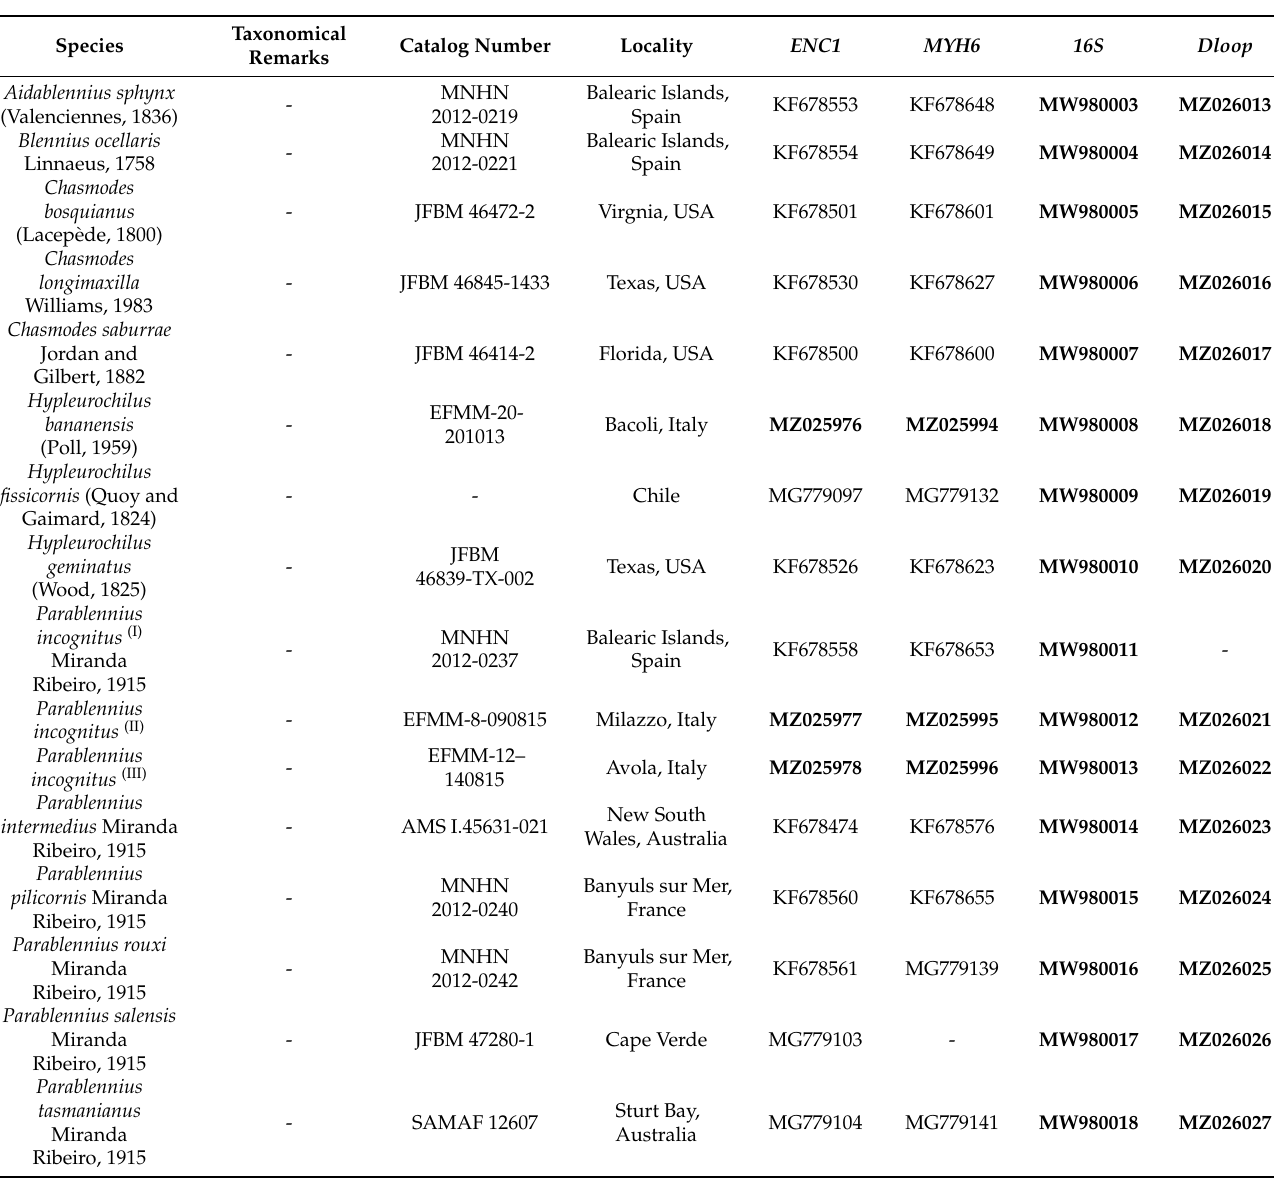
Table 1. List of species sampled, catalog number, locality, and GenBank accession number for molecular loci sampled. Novel GenBank accession numbers are reported in bold. * Salariopsis gen. nov. Roman numbers in brackets refer to analysed specimens shown in Figure